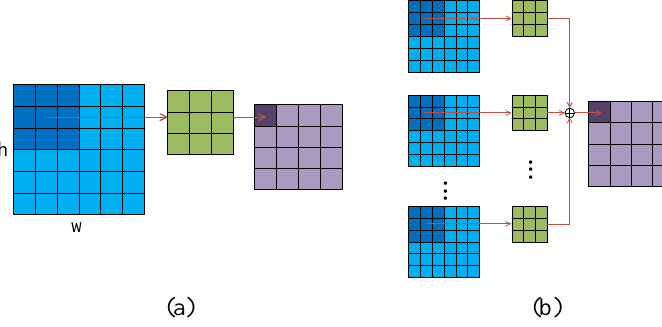
Figure 1. Illustrations of vanilla 2D convolution. ( a ) When the input is a single h × w map, each kernel is k × k and the corresponding output is a 2D ( h − k + 1 ) × ( w − k + 1 ) map. ( b ) When the input is c numbers h × w maps, each kernel is k × k × c . Doing the same operation on each channel as in (a), getting c 2D maps and add them up. The outputs of two sub-graphs are 2D maps with the same